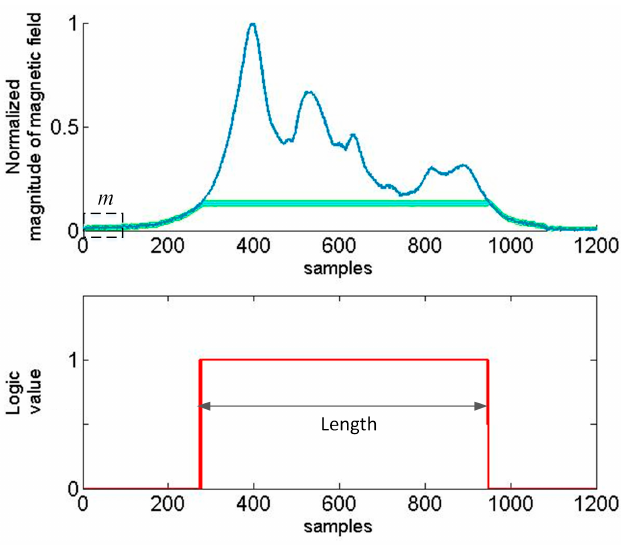
Figure 6. Toyota Avensis—the magnitude signature length computation with 3SD and running average of 100 samples.